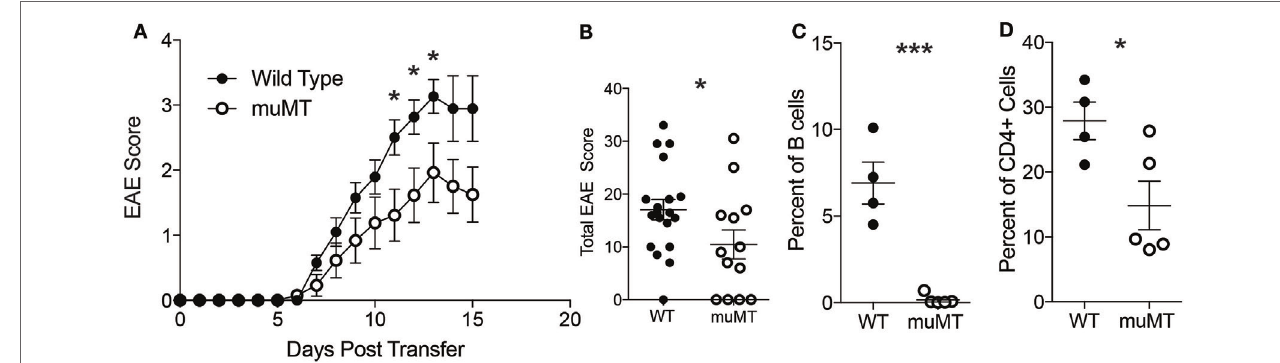
FigUre 2 | B cell deficient mice have reduced TH17-experimental autoimmune encephalomyelitis (EAE) disease severity. (a) Daily disease scores of TH17-EAE were compared in C57BL/6 mice and μ MT. N = 20–21 mice per group compiled from three independent experiments. Statistical significance at each day was determined using a Mann–Whitney test (* p < 0.05). (B) The cumulative disease scores from (days 0 to 15) were compared in the C57BL/6 and μ MT mice. Statistical significance was determined using a Mann–Whitney test (* p < 0.05). At the peak of disease, percent of viable cells which were (c) CD19 + B220 + B cells and (D) CD4 + T cells in C57BL/6 and μ MT mice spinal cords were assessed by flow cytometry. N = 4–5 mice per group were analyzed. Statistical significance from was determined using Student’s t -test (* p < 0.05, *** p <